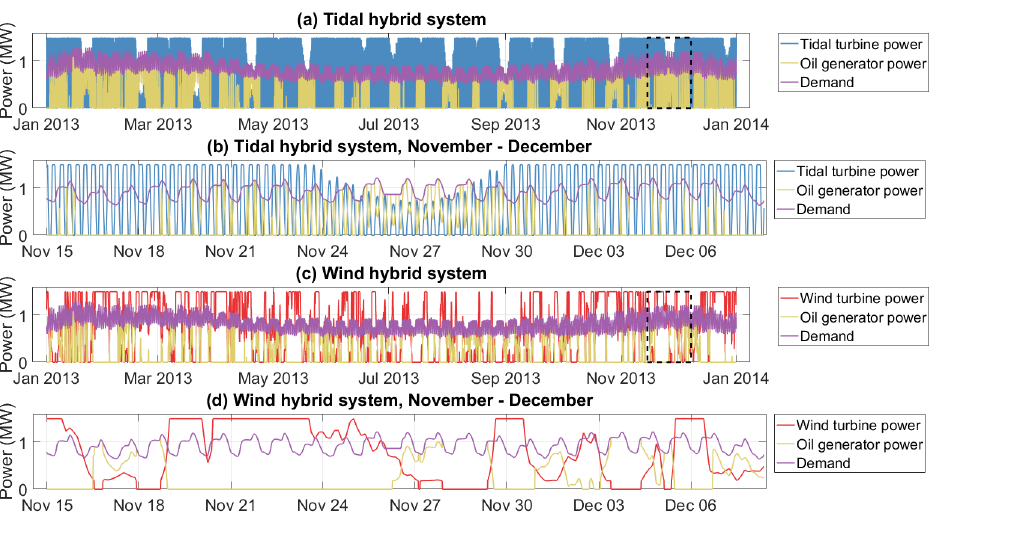
Figure 7. Turbine power, oil generator power and demand from the ( a , b ) tidal and ( c , d ) wind hybrid systems over periods spanning 2013 ( a , c ) and a 3 week period across November and December ( b , d